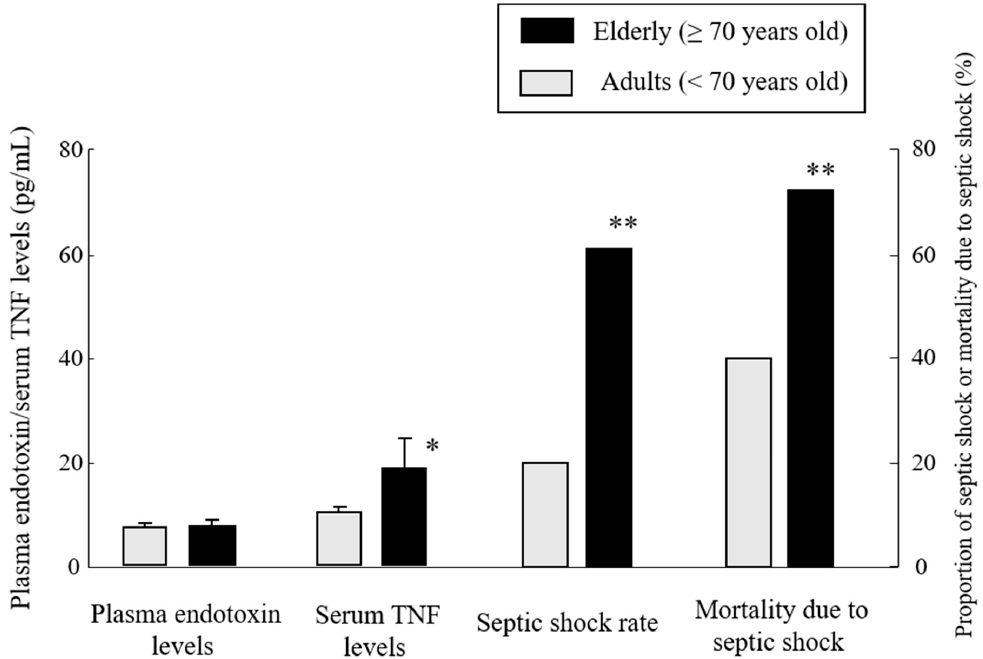
Figure 6. Characteristics of septic shock in elderly patients. Plasma endotoxin levels, serum TNF levels, proportion of septic shock rates, and mortality due to septic shock were compared between elderly and young adult septic patients. Though both patient groups showed similar plasma endotoxin levels, the elderly patients showed markedly higher serum TNF levels and septic shock rates, leading to a high mortality due to septic shock. Data are means ± SE or mean from 18 elderly patients and 20 young adult patients. ** p < 0.01, * p < 0.05, using the Mann–Whitney U -test and chi-squared test. Figure data are revised from [21].